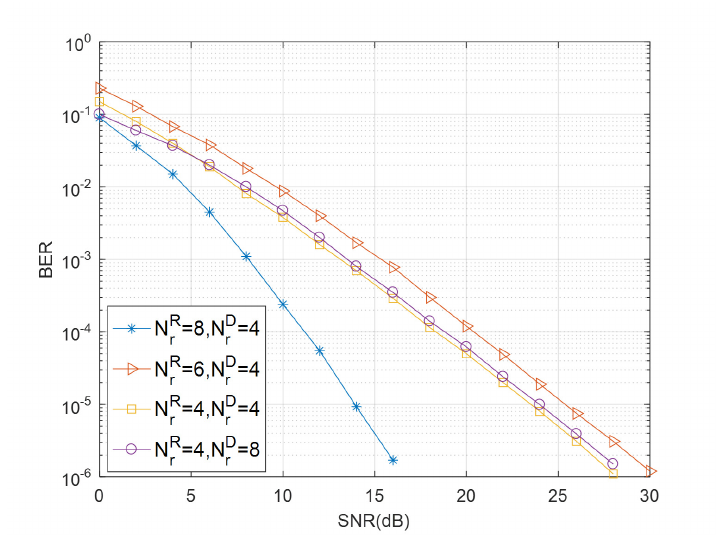
Figure 3. Bit Error Rate (BER) performance of a different number of receive antennas of STBC-CMIMO = N R = 4 with BPSK modulation. for N S t t